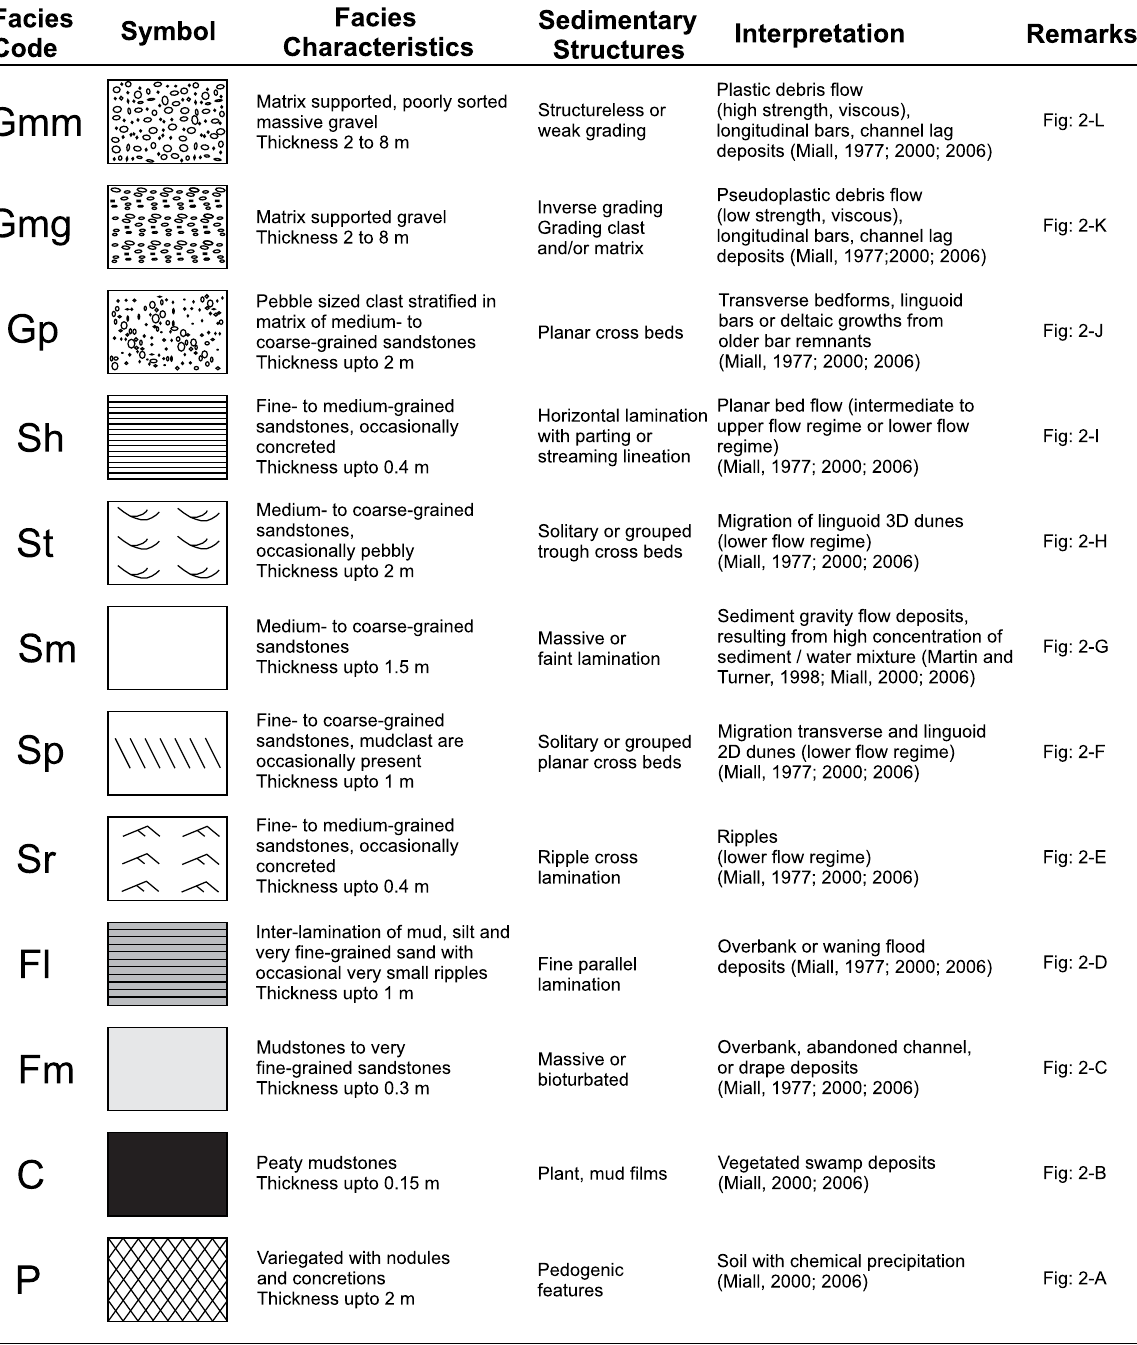
Table 1 Description and interpretation of the depositional facies of the Siwalik Group along the Muksar Khola